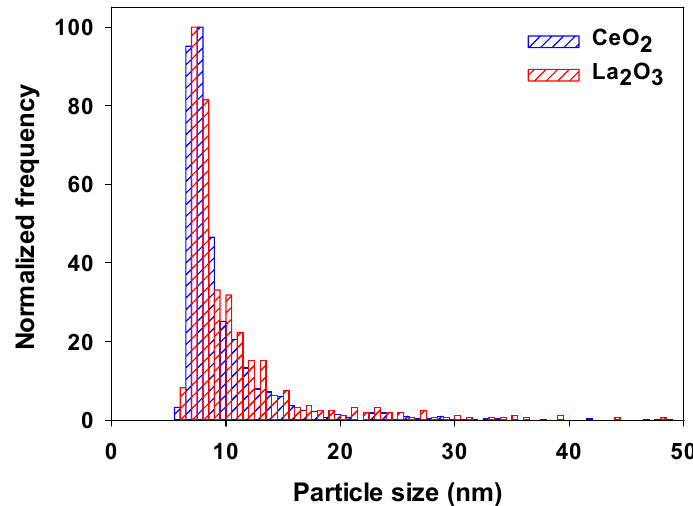
Figure 6. Particle size distributions of Ce- (blue) and La-(red) containing NPs found in a Montreal rainwater. Particle size distributions were calculated by assuming spherical particles of pure CeO 2 (density = 7.13 kg dm − 3 ) [23] and La 2 O 3 (density = 6.51 kg dm − 3 ) [36]. Measurements were obtained using the wet-SF-ICP-MS with a 50 µs dwell time.